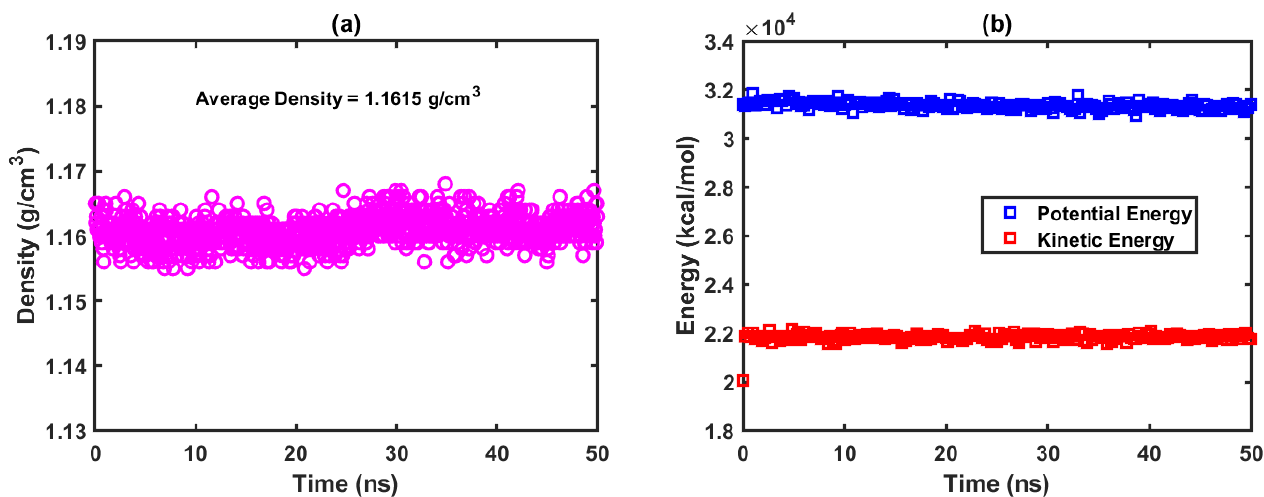
Figure 3. ( a ) Density vs. time profile; ( b ) cohesive energy vs. time profile for the